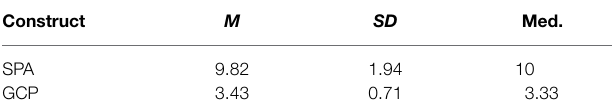
TABLE 5 | Performance